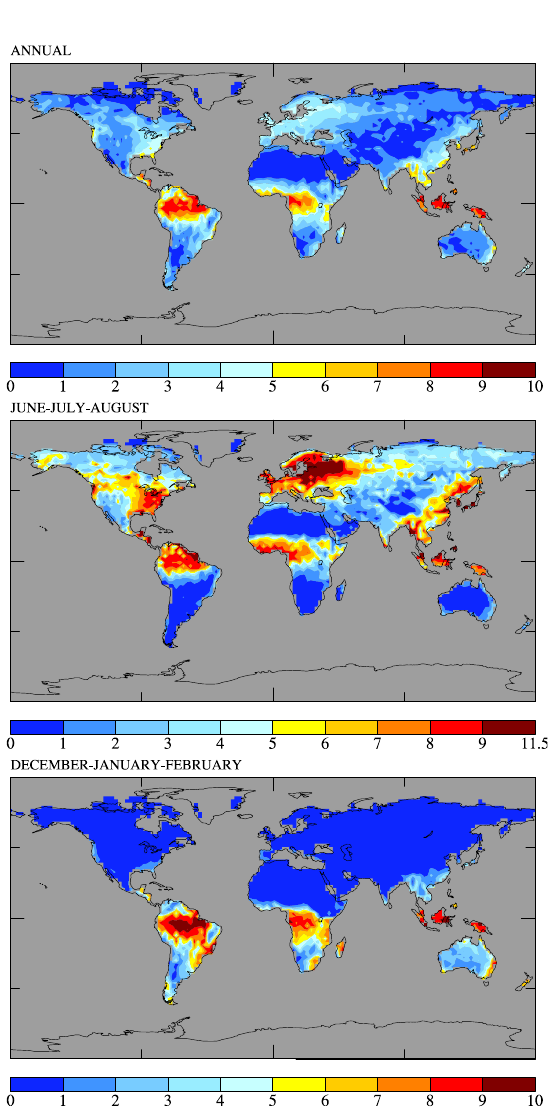
Fig. 1a. Spatial distribution of annual and seasonal average modeled GPP in gCm − 2 day − 1 in the control run SimCONT.